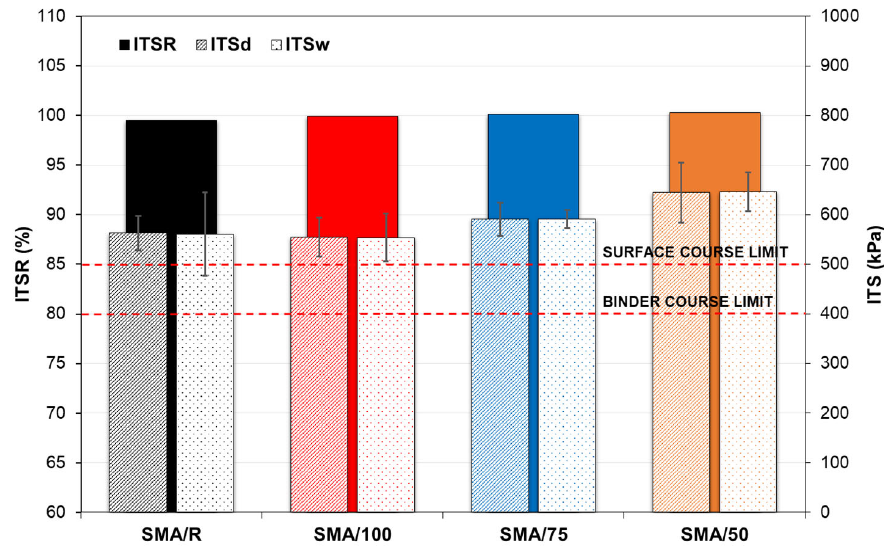
Figure 11. Moisture sensitivity test results.